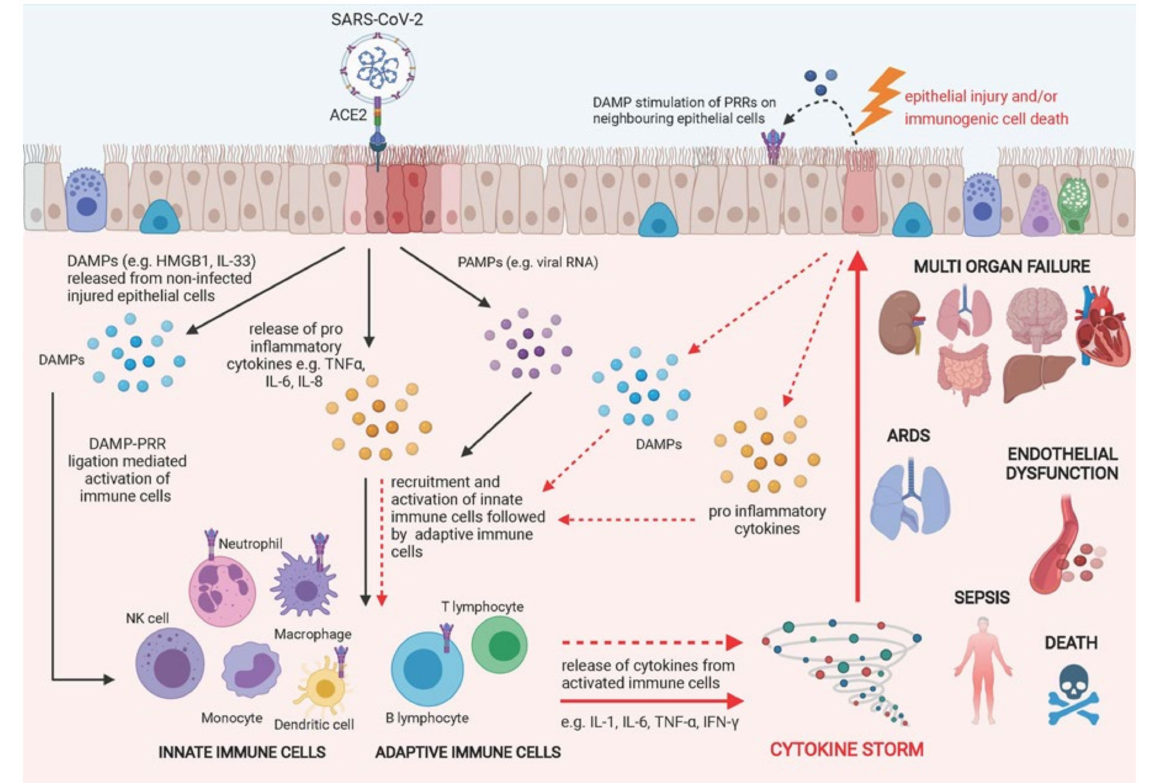
Figure 4. Schematic diagram of downstream effects of epithelial damage in COVID-19. COVID-19 infection oc- curs when the severe acute respiratory syndrome coronavirus 2 (SARS-CoV-2) spike protein binds to surface receptor angiotensin-converting enzyme 2 (ACE2) on pulmonary epithelial cells, stimulating the release of PAMPs, DAMPs and cytokines/chemokines into the cellular microenvironment and causing the recruitment and activation of innate immune cells followed by adaptive immune cells to the site of damage. In most circumstances, the immune response is capable of resolving infection and restoring tissue homeostasis. However, this process can become dysregulated, resulting in a hyper inflammatory response termed a ‘cytokine storm’, which can cause further damage to the pulmonary epithelium in a positive feedback loop. Damaged epithelial cells stimulate the release of more pro-inflammatory chemokines/cytokines and DAMPs, exacerbating epithelial cell damage and death. Cytokine storm syndrome is considered to be one of the major causes of acute respiratory distress syndrome (ARDS), endothelial dysfunction, sepsis and multiple-organ dysfunction in humans, causing a rapid decline in lung function and ultimately death. Created using